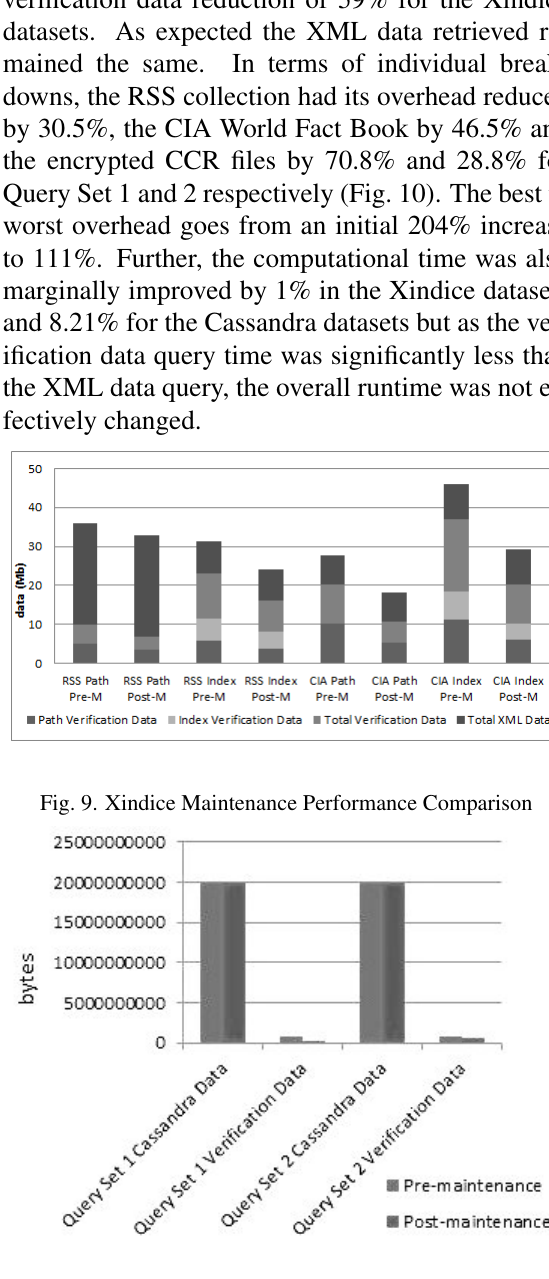
Fig. 10. Cassandra Maintenance Performance